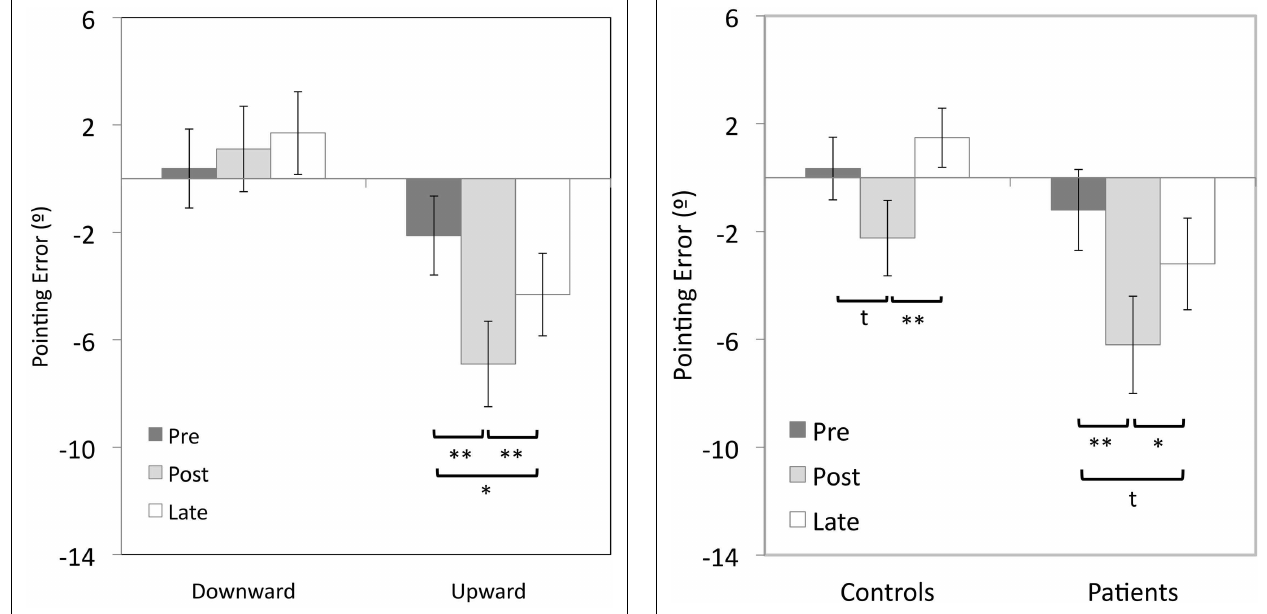
FIGURE 1 |Vertical errors (˚) for open-loop pointing movements made by healthy participants in Experiment 1 immediately before (pre-test) and after prism adaptation (post-test), and after the completion of the post-adaptation stepping task (late-test). Positive values indicate upward errors, negative values indicate downward errors. * p < 0.05, ** p s < 0.01, error bars represent ± 1 SEM.